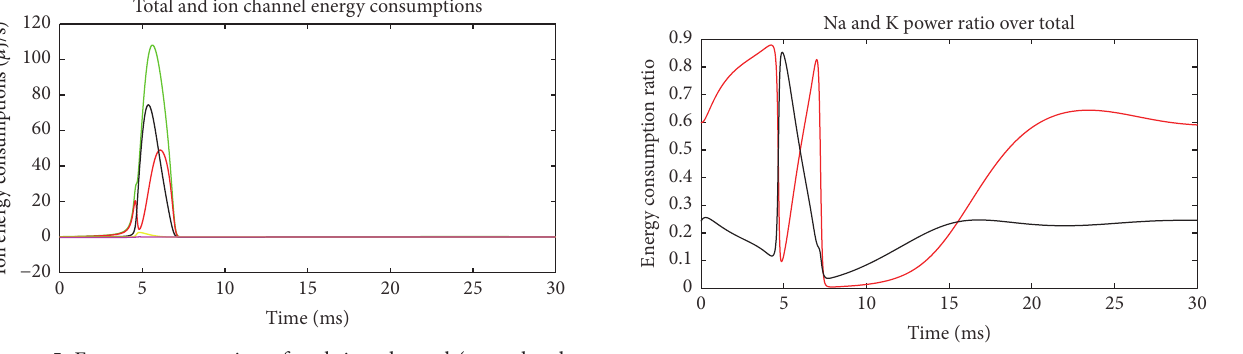
Figure 7: Power ratios of Na + and K + over total (suprathreshold).